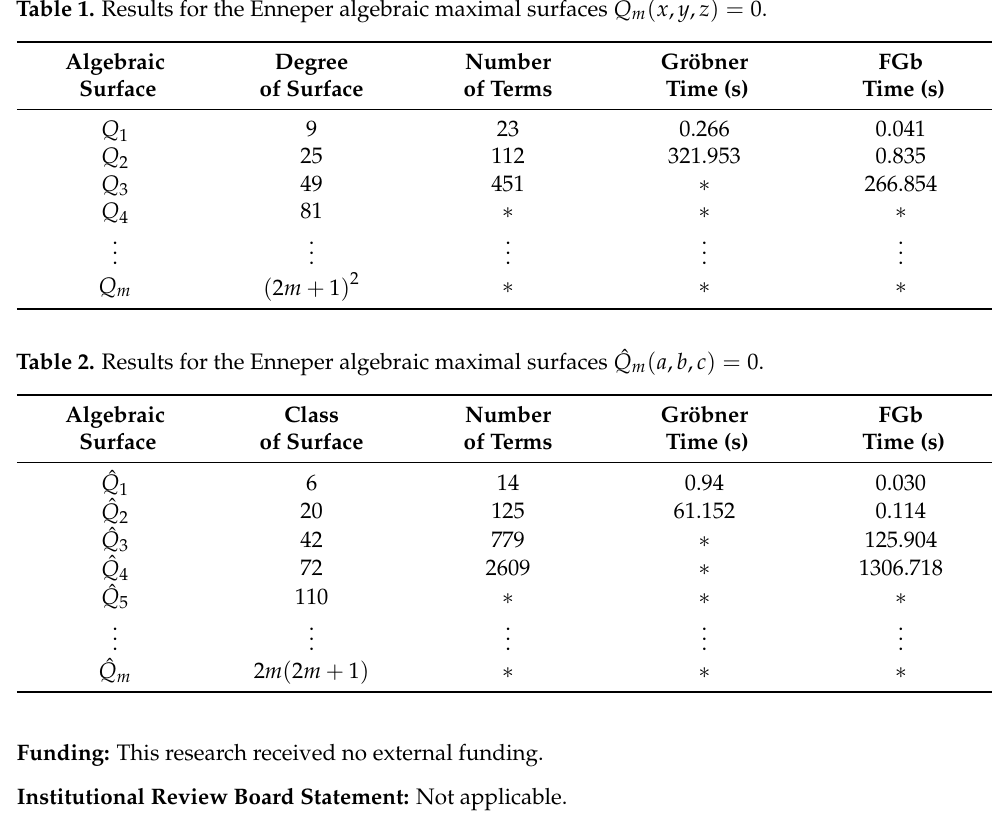
Table 1. Results for the Enneper algebraic maximal surfaces Q m ( x , y , z ) = 0. Algebraic Degree Surface